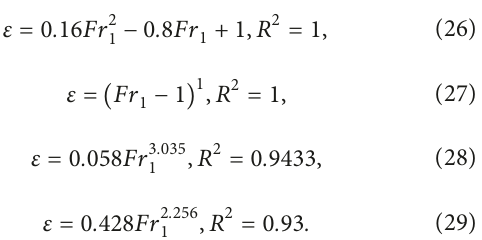
Figure 12: Measured and computed values of L (equation